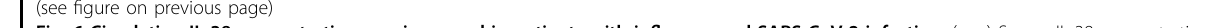
Fig. 6 Circulating IL-38 concentration was increased in patients with in fl uenza and SARS-CoV-2 infection. ( a , e ) Serum IL-38 concentration was measured by using ELISA of healthy controls ( n = 59), in fl uenza patients ( n = 50), and COVID-19 patients ( n = 85) on the day of hospitalization. Each dot represents a measurement of an individual patient, with horizontal lines denoting medians. ( b ) Serum IL-38 concentration of in fl uenza patients ( n = 24) in the acute and recovery phases was measured by ELISA. ( c , g ) Serum IL-36 α concentration was measured by using ELISA in healthy controls ( n = 50), in fl uenza patients ( n = 44), and COVID-19 ( n = 79) patients on the day of hospitalization. ( d ) Serum IL-36 α concentration of in fl uenza patients ( n = 45) in the acute and recovery phases was measured by ELISA. ( f ) Serum IL-38 concentrations in COVID-19 patients with mild ( n = 59) and severe ( n = 26) symptoms. ( h ) Serum IL-36 α concentrations in COVID-19 patients with mild ( n = 55) and severe ( n = 24) symptoms. ( i – k ) Correlation analysis of serum IL-38 concentration with CRP levels, LDH levels, duration of hospitalization in patients with SARS-CoV-2 ( n = 61, 82, 76, respectively). ( l – n ) Correlation analysis of serum IL-36 α concentration with CRP levels, LDH levels, duration of hospitalization in patients with SARS- CoV-2 ( n = 53, 67, 61, respectively). ( o – p ) Correlation analysis of serum IL-38 levels with viral load in nasopharyngeal swab specimens ( o ) and sputum ( p ) of patients with SARS-CoV-2 ( n = 73, 36, respectively). ( q , r ) Correlation analysis of serum IL-36 α levels with viral load in nasopharyngeal swab specimens ( q ) and sputum ( r ) of patients with SARS-CoV-2 ( n = 62, 34, respectively). Data were shown as (means ± SEM). Student paired t test and/or Mann – Whitney test was used to compare the differences between groups. Spearman correlation coef fi cient was used in the statistics for correlation analysis. * P < 0.05, ** P < 0.01, *** P < 0.001, and **** P <